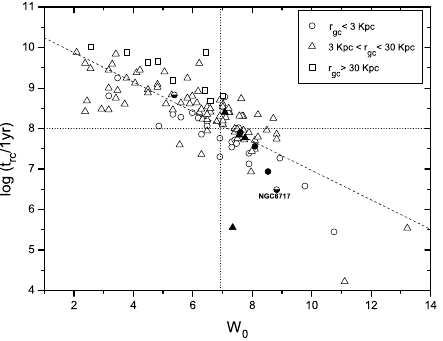
Figure 9: Behavior of t rc in function of W 0 ; three classes of cluster distances are represented. Vertical